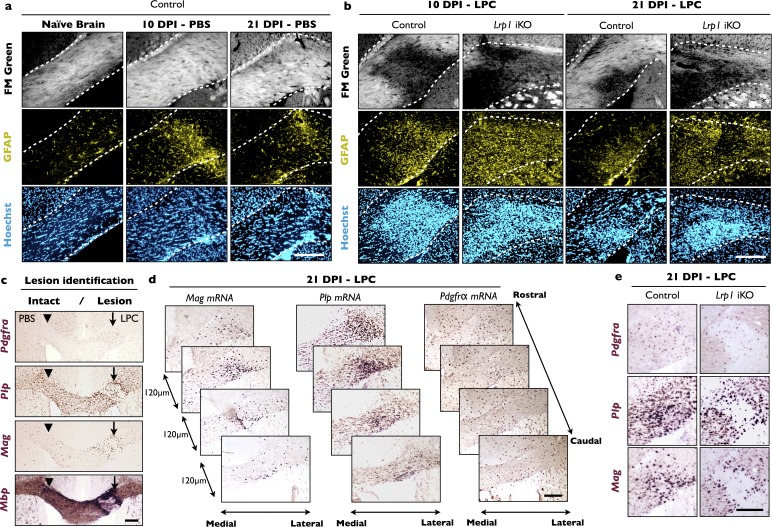
LPC injection into the corpus callosum leads to focal white matter damage and upregulation of myelin-associated gene products.(a) Coronal forebrain sections of adult Lrp1 control (naive) mice and mice subjected to stereotaxic injection of PBS into the corpus callosum. At 10 days post injection (10 DPI) and 21 DPI of PBS, brains were collected, serially sectioned, and stained with FM Green, anti-GFAP and Hoechst dye33342. The white dotted lines demarcate the corpus callosum. The injection site is readily identified by the elevated GFAP immunoreactivity. (b) Coronal forebrain sections of Lrp1 control and iKO mice at 10 DPI and 21 DPI of LPC stained with FM Green, anti-GFAP, and Hoechst dye33342. White dotted lines demarcate the corpus callosum. The white matter lesion is identified by the absence of FM Green labeling. Scale bar = 200 µm. (c) Serial coronal-sections of adult brain after PBS and LPC injection in the corpus callosum, probed for Pdgfra, Plp1, Mag, and Mbp mRNA expression to identify the lesion area and to examine gene expression changes in the OL lineage. The site injected with PBS is marked by an arrowhead and the LPC injection site is marked by an arrow. The lesion boarder shows elevated staining for Plp1, Mag and Mbp. Scale bar = 200 µm. (d) Serial brain sections of adult Lrp1 control mice injected with LPC at 21 DPI. Serial sections through the lesion area (120 µm apart) were probed for Mag, Plp1, and Pdgfra, mRNA expression. Scale bar = 200 µm. (e) Coronal brain sections through the CC including the lesion center of Lrp1 control and Lrp1 iKO mice injected with LPC at 21 DPI. Serial sections were probed for Pdgfra, Plp1, and Mag mRNA expression. Scale bar = 200 µm.